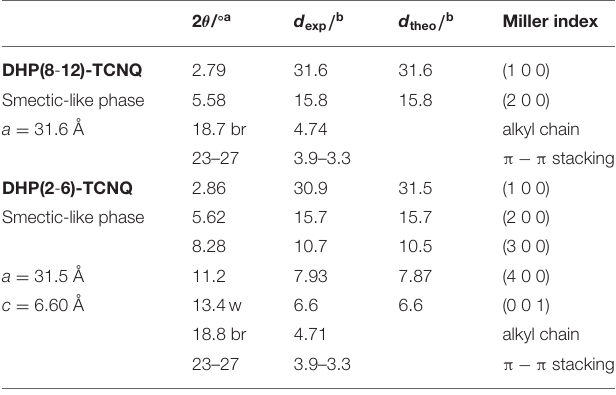
TABLE 2 | XRD data for DHP(8-12)-TCNQ and DHP(2-6)-TCNQ after the rubbing